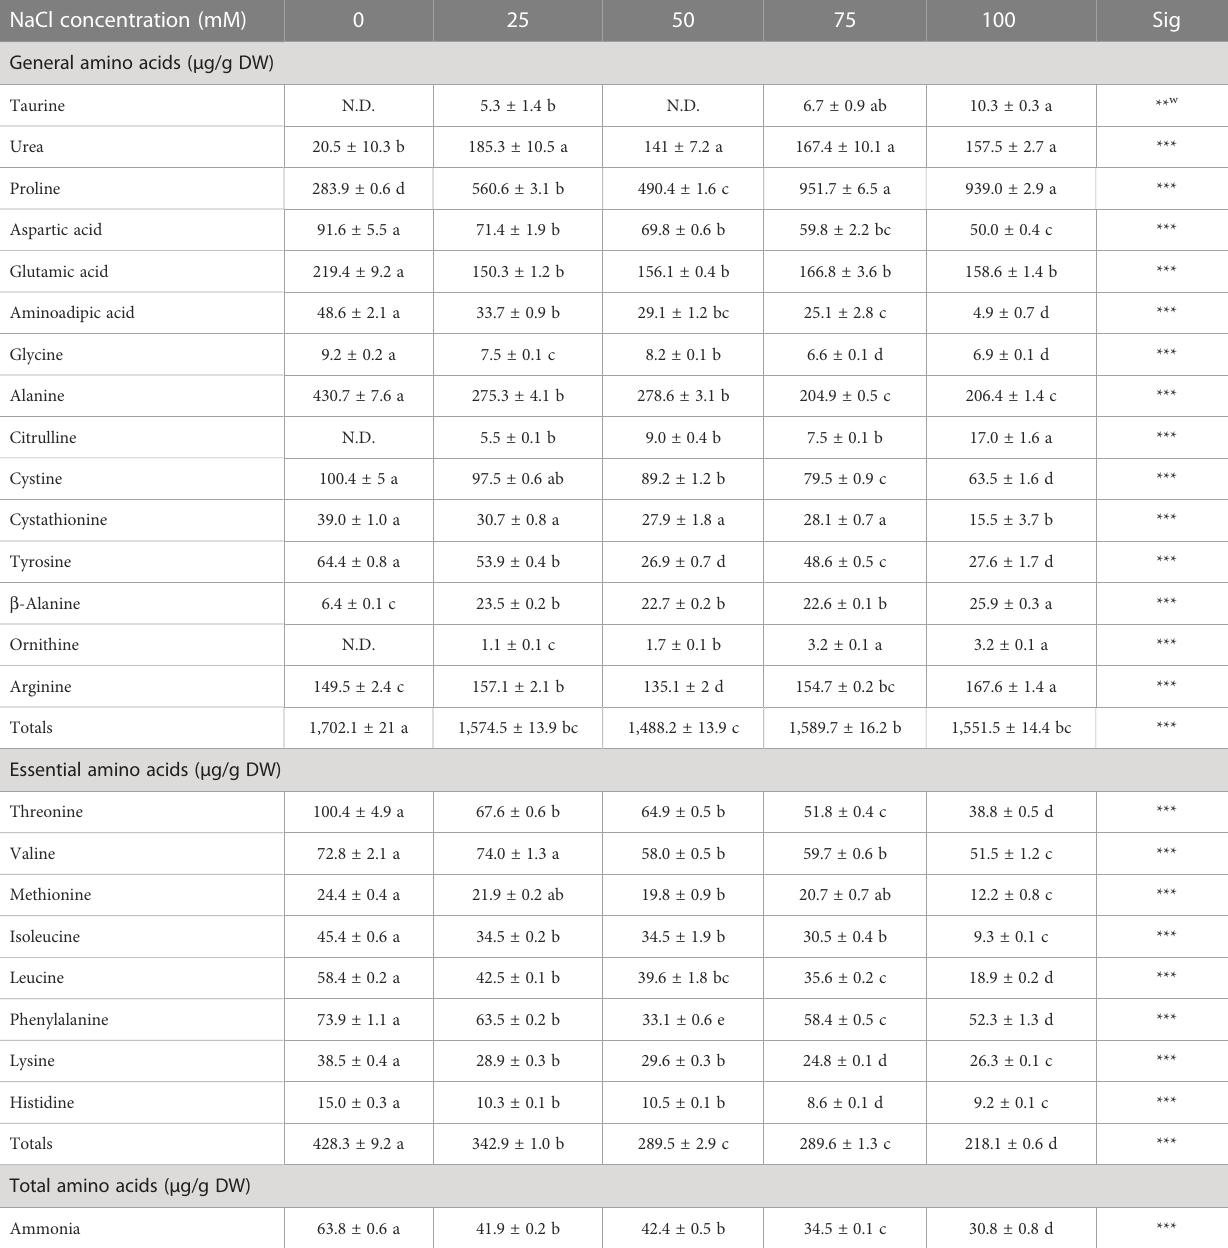
TABLE 3 Free amino acids of Limonium tetragonum under different NaCl